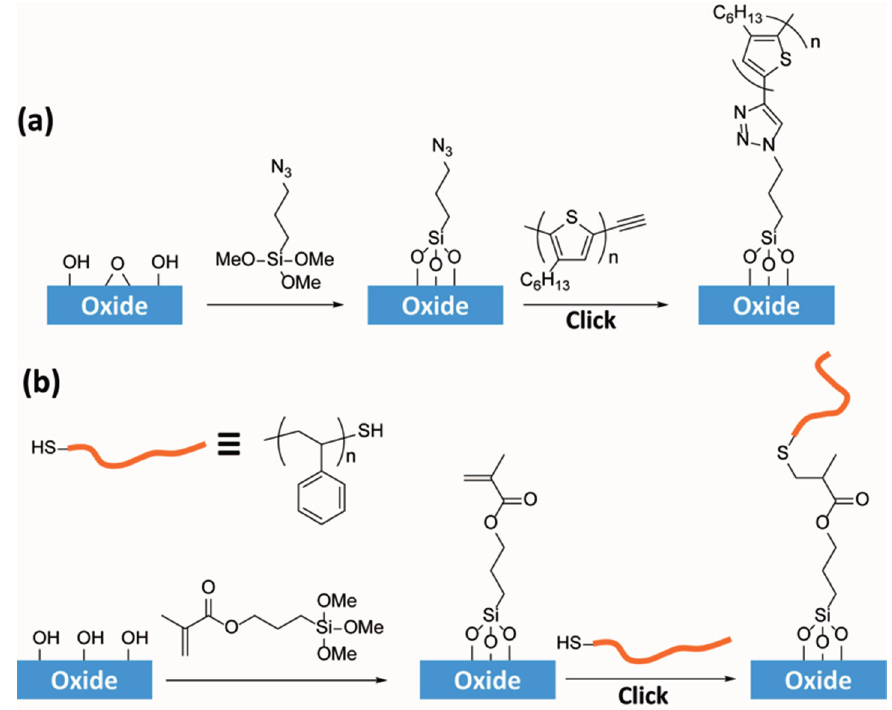
Figure 4. Examples of solution based “grafting-to” through click chemistry. ( a ) Anchoring ethynyl-terminated P3HT onto azide functionalized surface (Redrawn from Reference [78], Copyright 2010, Royal Society of Chemistry); and ( b ) Use of thiol-ene click chemistry (Redrawn from Reference [83], Copyright 2014, American Chemical